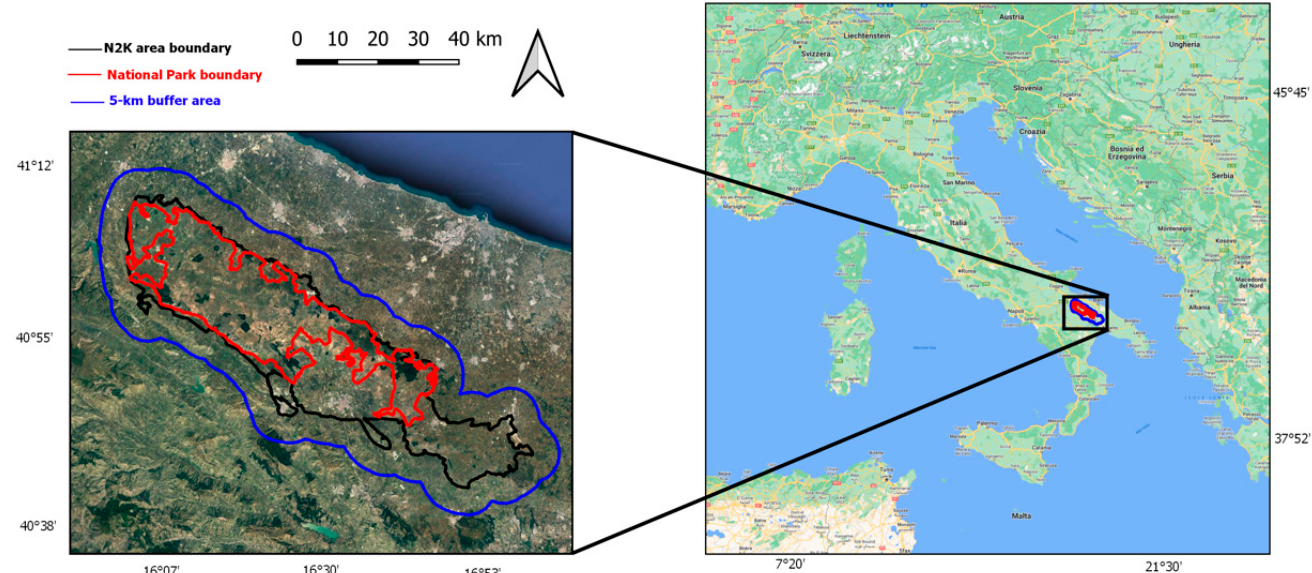
Figure 1. “Murgia Alta” study site, southern Italy. The N2K PA, the National Park and the 5-km buffer area in black, red and blue boundaries, respectively, overlaid on a Google satellite